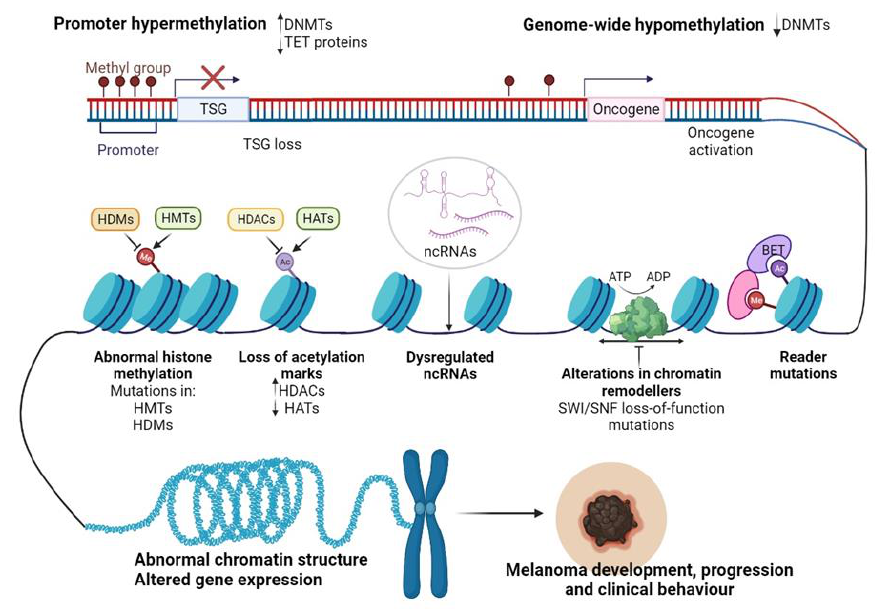
Figure 2. Epigenetic changes regulating CM progression and clinical behavior. Abbreviations: